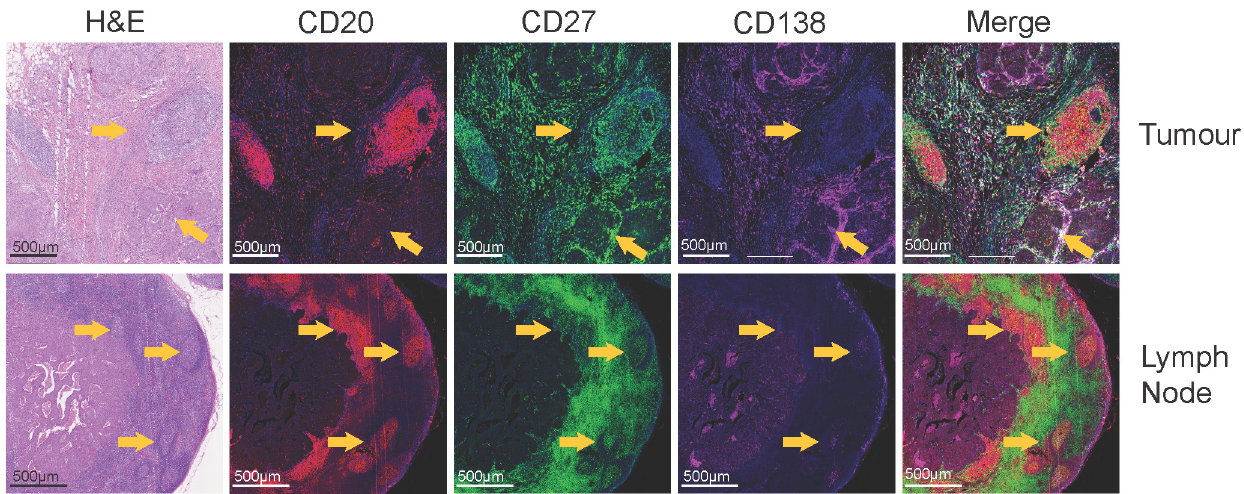
Figure 2. Histological identification of TLS and germinal centres within tumour and LN. The top row displays images of a primary breast tumour with TLS stained with: H&E, CD20, CD27, CD138, and merge of CD20 (red), CD27 (green), and CD138 (magenta). Dense CD20+ B cell areas of the TLS are surrounded by CD27+ cells and dispersed plasma cells. Yellow arrows indicate TLS. The bottom row shows a metastatic LN from the same patient exhibiting germinal centre formation, stained with: H&E, CD20, CD27, CD138, and merge of CD20 (red), CD27 (green) and CD138 (magenta). Yellow arrows indicate germinal centres.